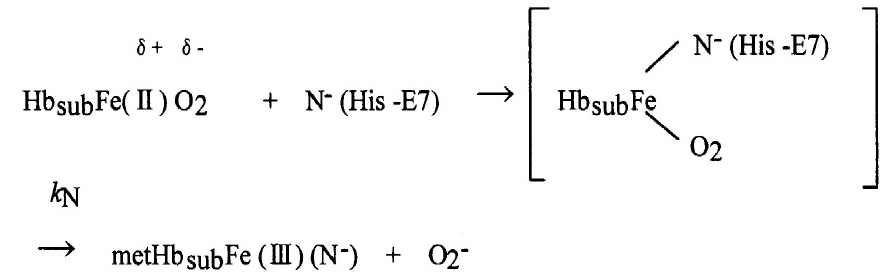
– β (and α – β ) interface in human 1 1 2 2 – β (and α – β ) interface produces a 1 1 2 2